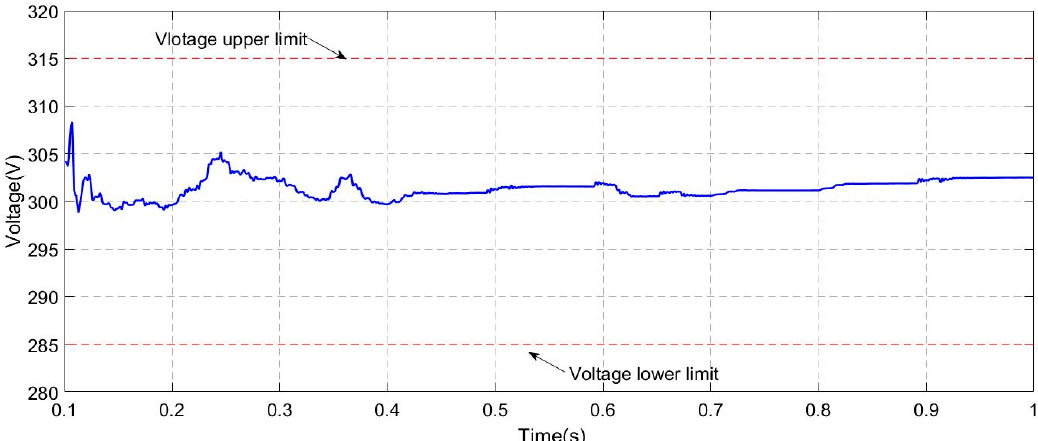
Figure 6. The waveform of PCC V under normal operation control mode.